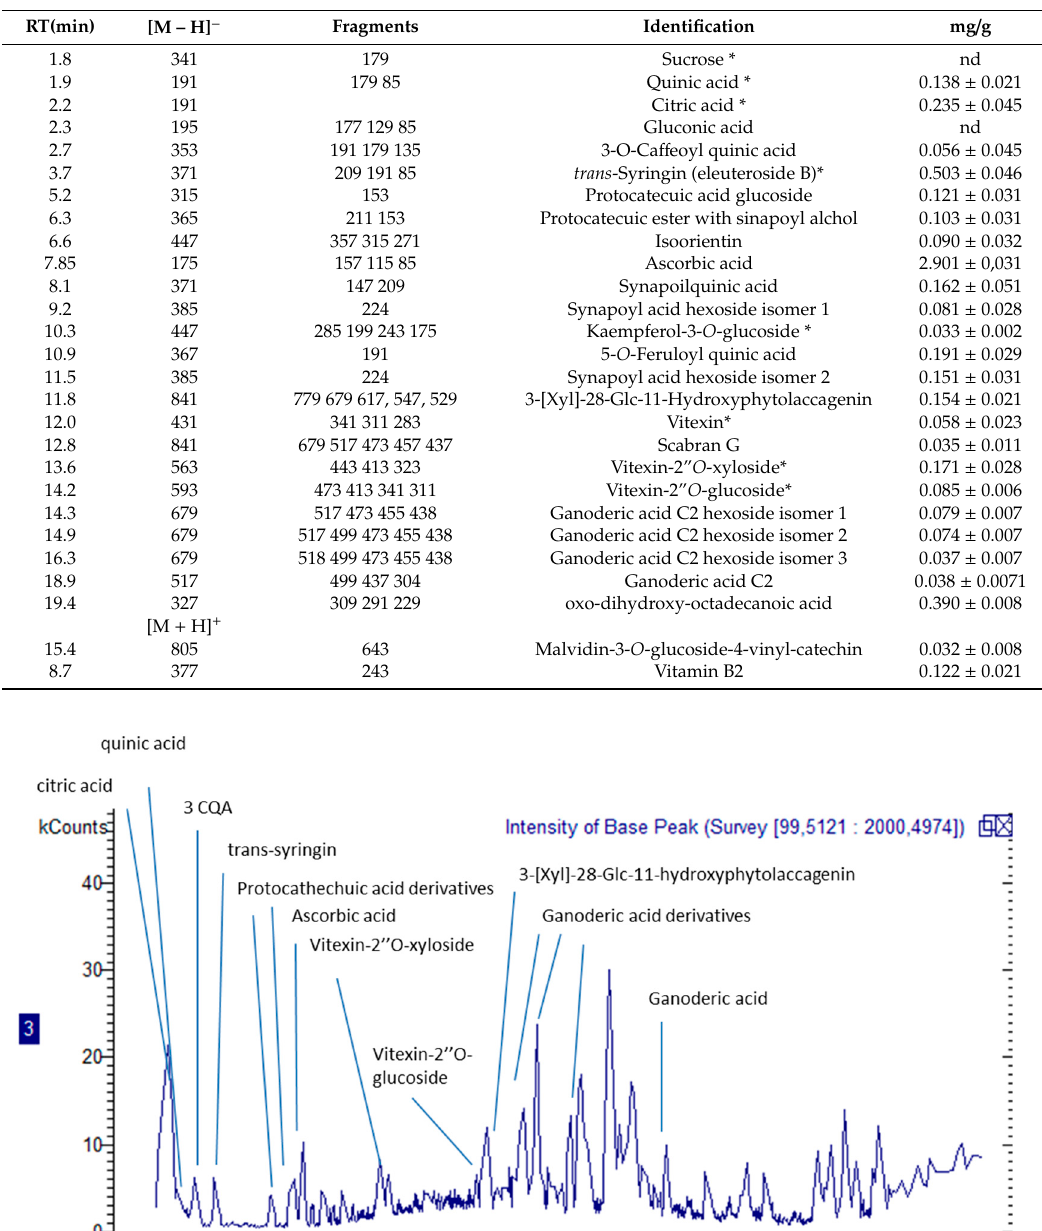
Table 2. Identified polar compounds in G. diversifolia extract by LC-DAD-ESI-MS, * indicate comparison with authentic standard.